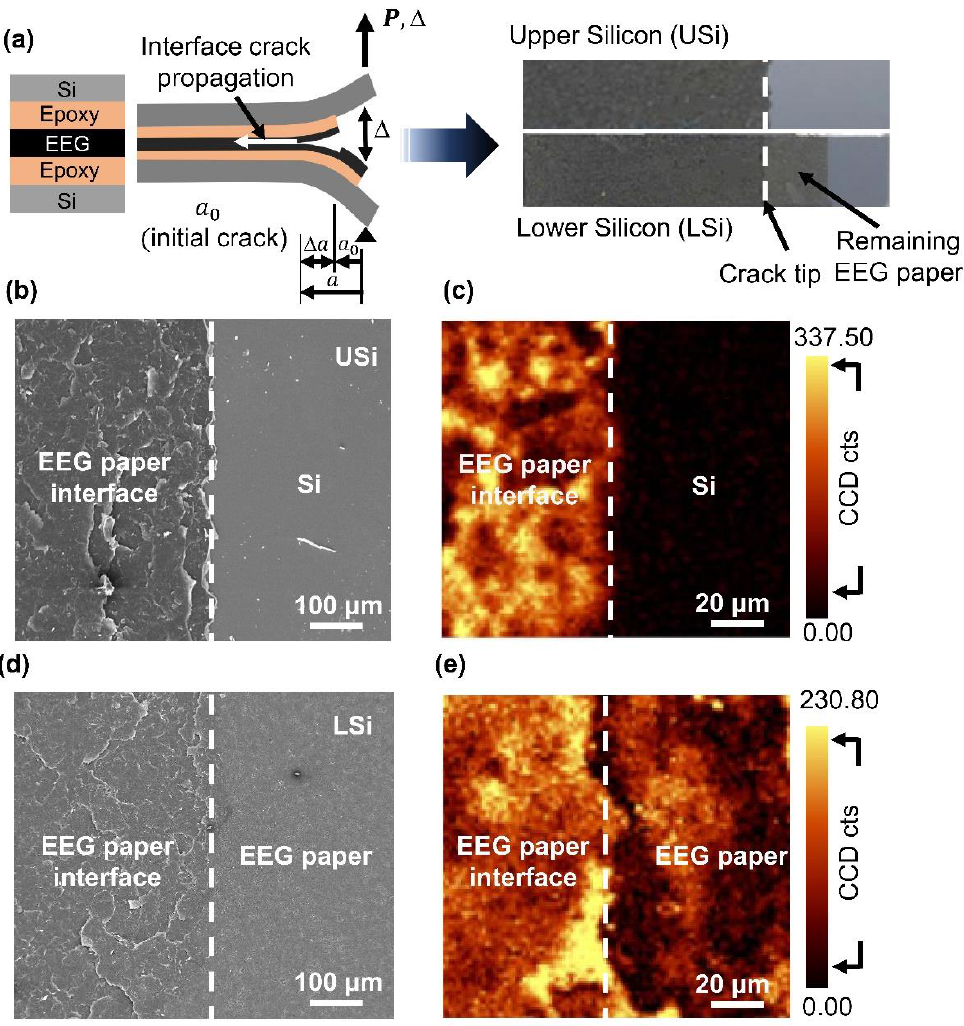
Figure 3. Characterization of the fracture surface of the EEG paper after the mode I fracture test: ( a ) schematic illustration of the interlayer separation in the EEG paper and a photograph of the DCB specimen after fracture; ( b , d ) SEM images and ( c , e ) Raman intensity maps of the D band for the fracture surfaces of the USi and LSi near the epoxy terminus.